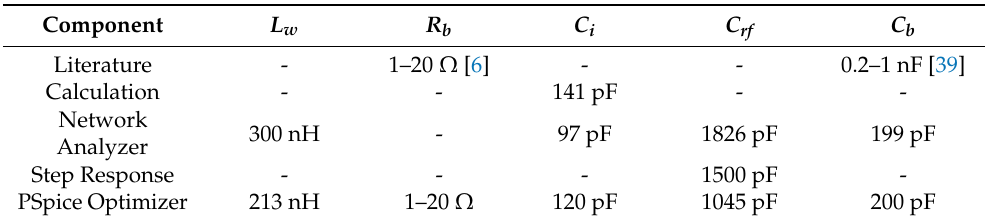
Table 1. Summary of modified IM circuit modeling component values with final values in the “PSpice Optimizer” row.